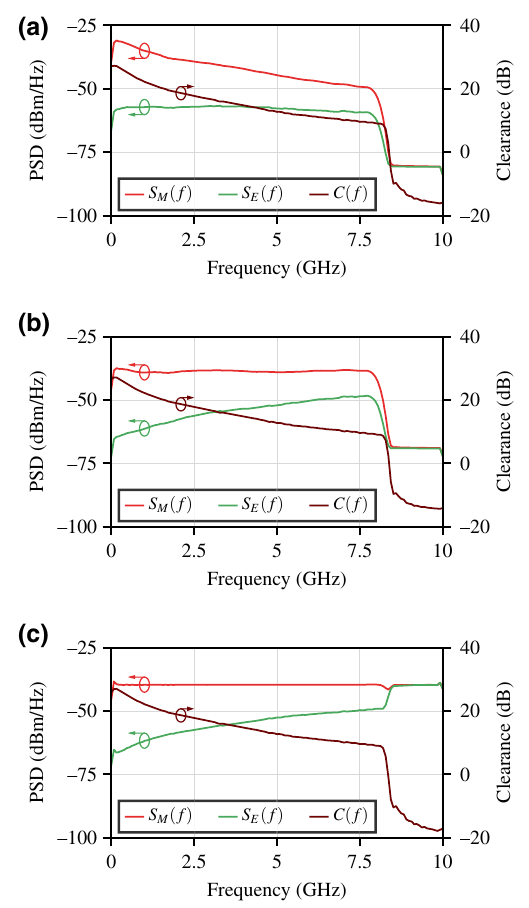
FIG. 7. The homodyne-measurement PSD S M ( f ) , excess- noise PSD S E ( f ) , and clearance C ( f ) for the cases where: (a) no equalizer, (b) an equalizer up to 8 GHz, and (c) an equalizer up to 10 GHz are used.